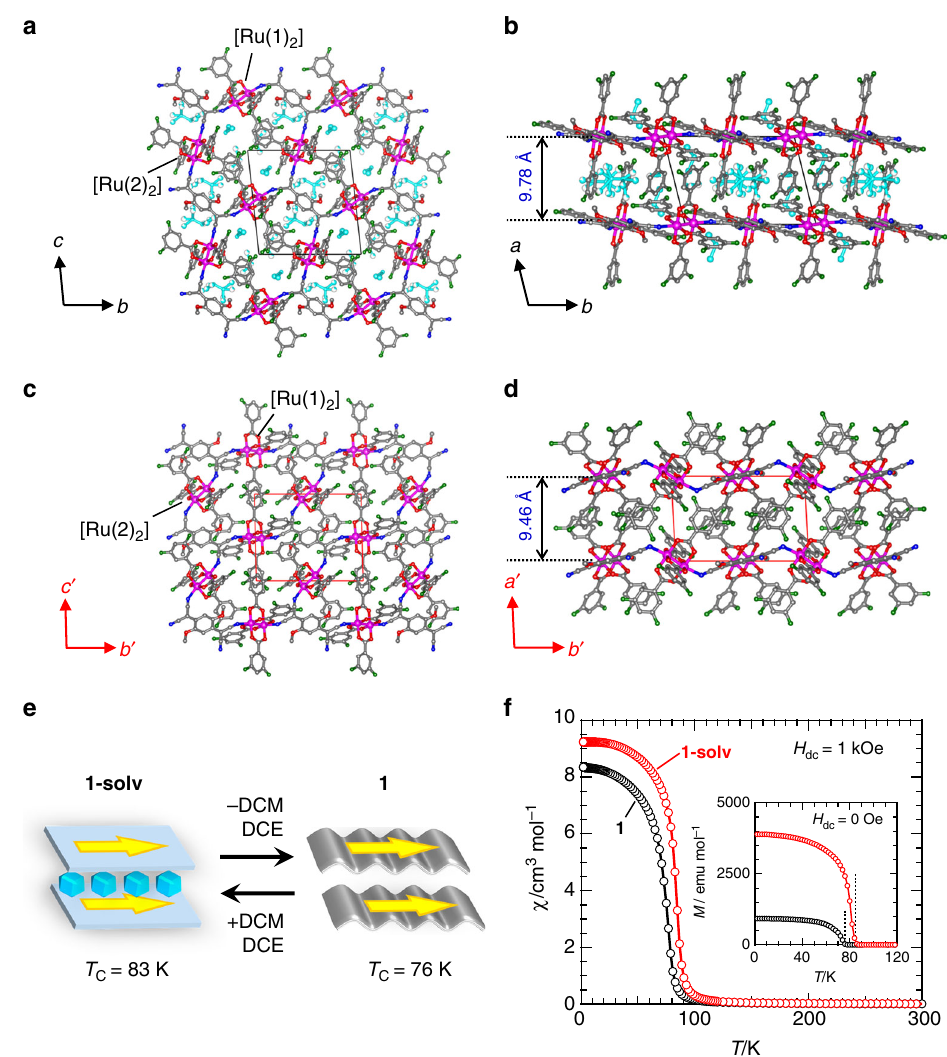
Fig. 1 Structural modulation and magnetic sponge behavior upon solvation/desolation. a – d Views of the crystal structures of 1-solv ( a , b ) and 1 ( c , d ); fi gures a , c and b , d show projections along the a ( a ’ ) axis and c ( c ’ ) axis, respectively, where atoms N, O, C, F, and Ru are represented in blue, red, gray, green, and purple, respectively, and the crystallization solvents given in fi gures a and b are represented in cyan. The vertical inter-layer distance ( l 1 ) is indicated in blue digit in b and d , and the inter-unit translational distance ( l 2 ) corresponds to the a - or a ′ -lattice axis for each compound (Supplementary Table 8). The cell axes a ′ – c ′ in c and d represent those for a transformed lattice (see Supplementary Methods), which were adopted for easy comparison with the lattice of 1-solv . e Schematic representation for the interchange between 1-solv and 1 upon solvation/desolvation, where the colored arrow indicates a plausible direction of ordered spins. f Temperature dependence of magnetic susceptibility ( χ ) for 1-solv (red) and 1 (black) measured under a 1 kOe dc fi eld ( H dc ) on fi eld cooled process. Inset: Remnant magnetization ( M ) at H dc = 0 Oe (heating process) measured after taking a FCM (1.8 – 120 K) under a 3 Oe dc fi eld, where the dashed lines indicate the respective T C